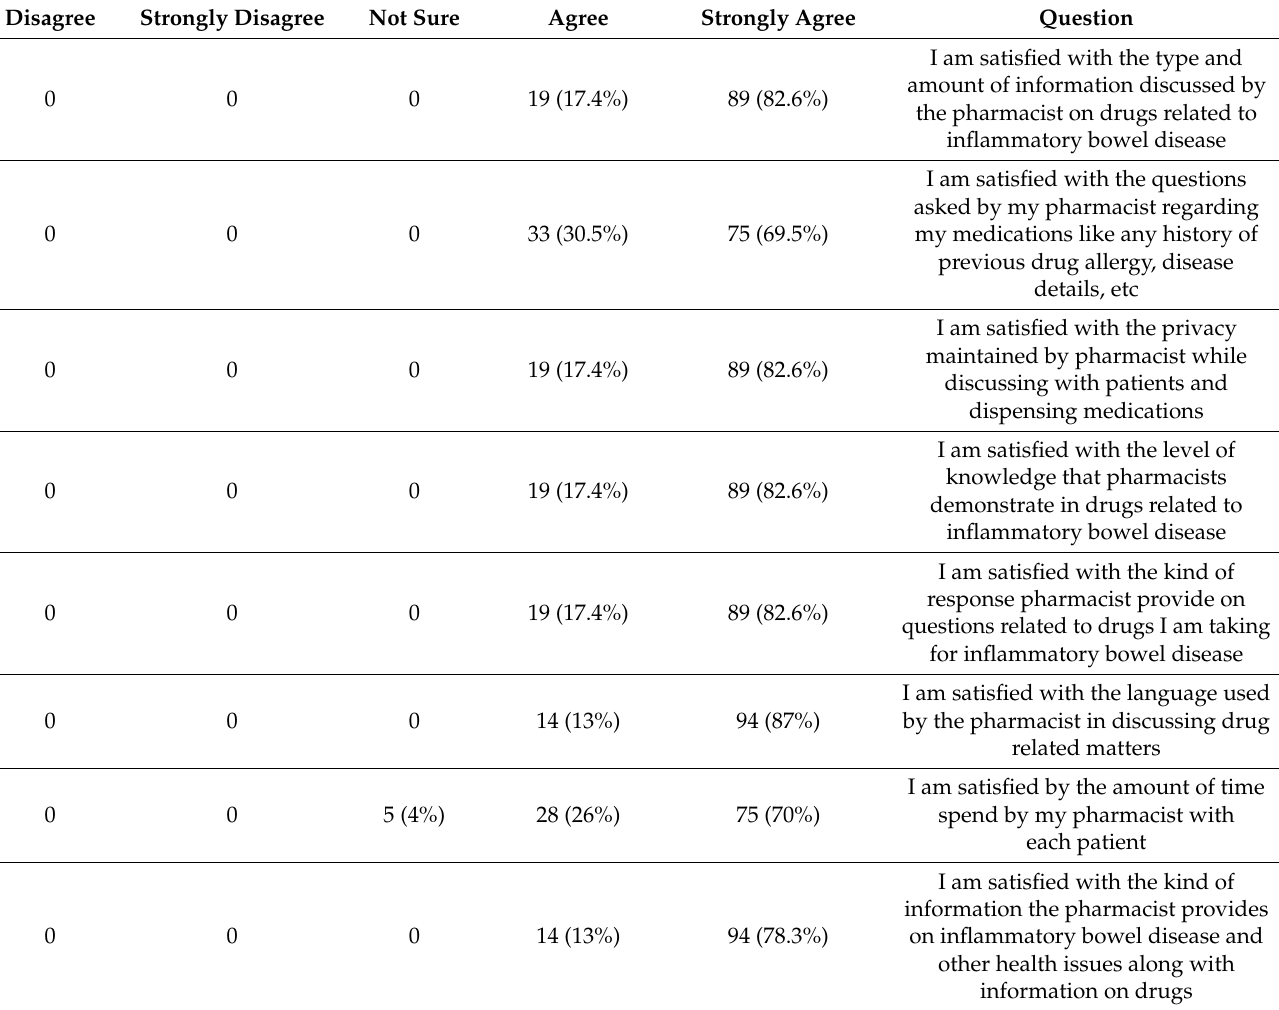
Table 2. Patients’ responses regarding their level of